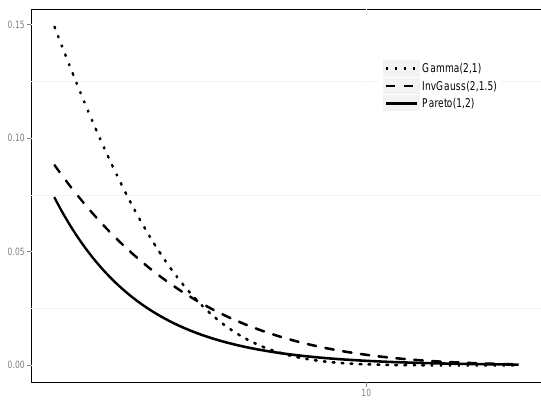
Figure 5. Tails of the three claim distributions involved in our